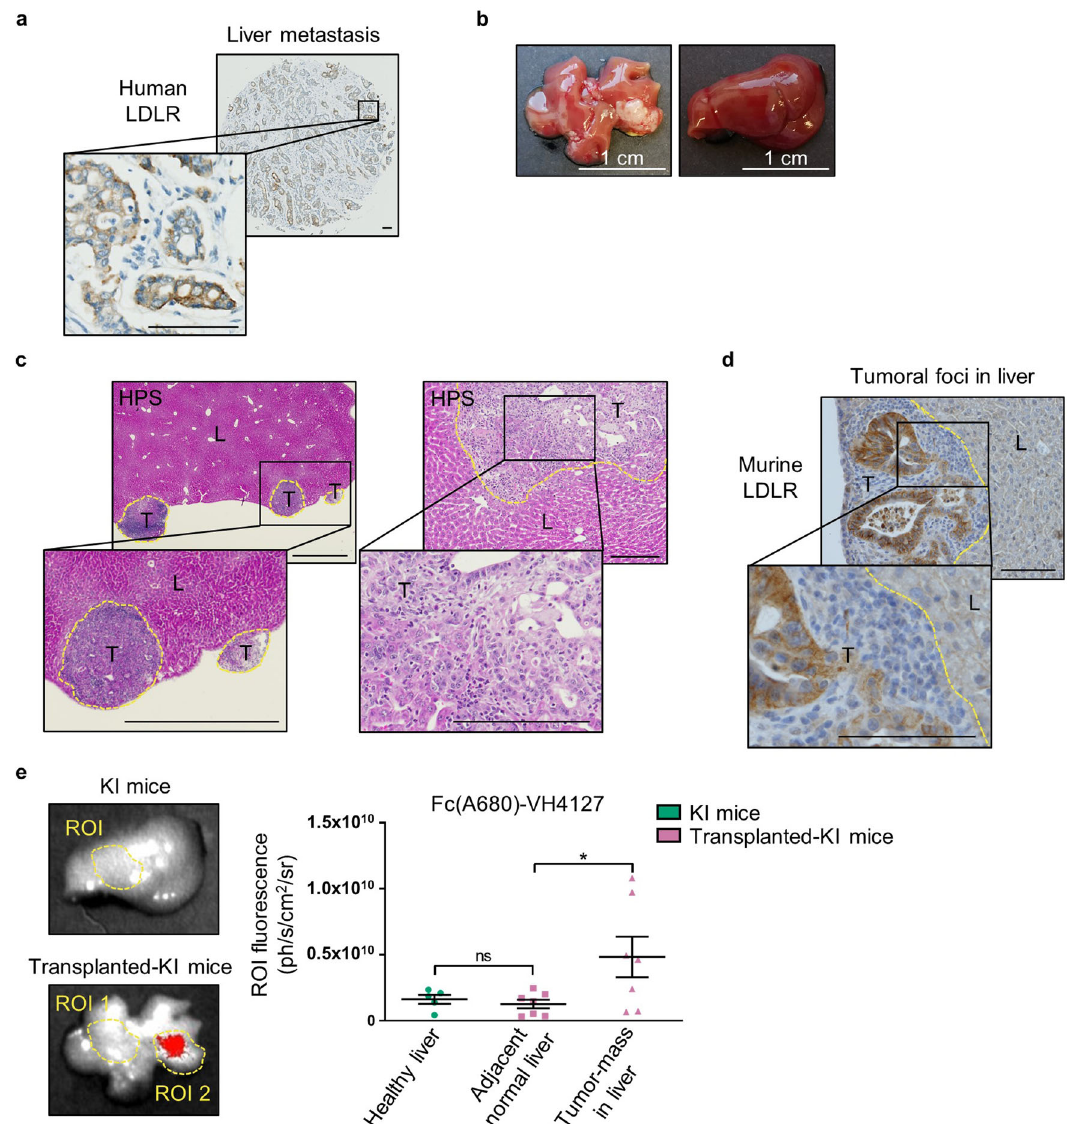
Fig. 6 The Fc(A680)-VH4127 conjugate detects pancreatic tumor mass in liver. a Representative IHC of LDLR in liver metastasis from PDAC resected patient. ×6.8 and ×20 magni fi cation, scale bar: 100 µ m. n = 2 independent samples. b Representative image of PDAC foci in liver from KI mice transplanted with PK4A cells (left) and of healthy liver from KI mice (right). c , d Representative Haematoxylin Phloxine Saffron (HPS) ( c ) and LDLR ( d ) staining of PDAC foci (T) in liver (L) of transplanted-KI mice, delimited by yellow dots. An enlarged image of indicated part is provided in inset box. n = 5 mice. c Left panel: ×2 magni fi cation, scale bar: 1000 µ m; right panel: ×10 magni fi cation, scale bar: 500 µ m. d ×20 magni fi cation, scale bar: 100 µ m. e Representative merged fl uorescence and visible light images of excised healthy- and tumoral liver from KI and transplanted-KI mice, respectively, obtained 48 h after retro-orbital IV injection of Fc(A680)-VH4127 (1 nmole/mouse). Quanti fi cation of ROI-speci fi c Fc(A680)-VH4127 signal relative to healthy pancreas from KI mice and to tumoral foci and adjacent normal liver from transplanted-KI mice. Data are expressed as mean (ph/s/cm 2 /sr) ± s.e.m. One-way ANOVA with post-hoc Tukey HSD test, ns: no signi fi cant difference, * p < 0.05. n = 5 and n = 7 KI and transplanted-KI mice, (Supplementary Table S1), is composed of 728 PDAC, 76 metastases (including 36 liver metastases), and 96 normal adjacent pancreatic samples. Other metastatic samples come from the peritoneum (29%), the lymph nodes (22%) and the lung (20%). This in silico meta-analysis was thus based upon data from published studies for which the informed patients ’ consent to participate and the ethics approval from the institutional review board were already obtained by the authors. The data analysis required pre-analytic processing. First, we separately normalized each DNA microarray-based dataset: individual Affymetrix dataset was normalized using robust multichip average with the non-parametric quantile algorithm for the raw Affymetrix data (Bioconductor and associated-packages, R software), while non-Affymetrix datasets were normalized with quantile normalisation procedure. Then, Agilent or Affymetrix hybridization probes were mapped across different technological platforms (Stanford Online Universal Resource for Clones and ESTs